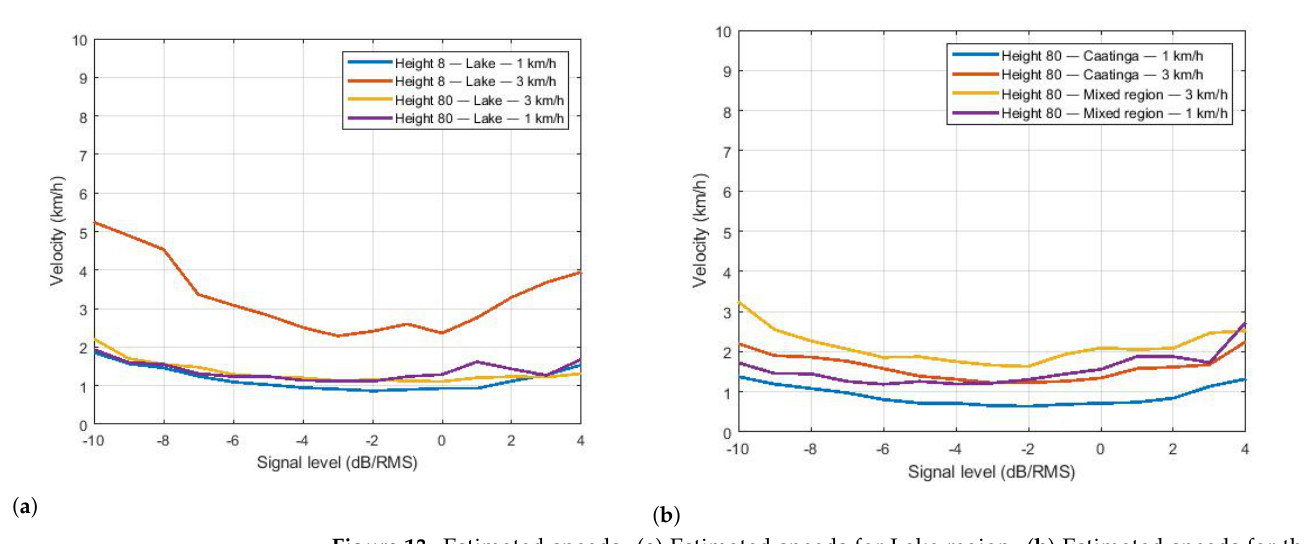
Figure 13. Estimated speeds. ( a ) Estimated speeds for Lake region. ( b ) Estimated speeds for the Caatinga and Mixed